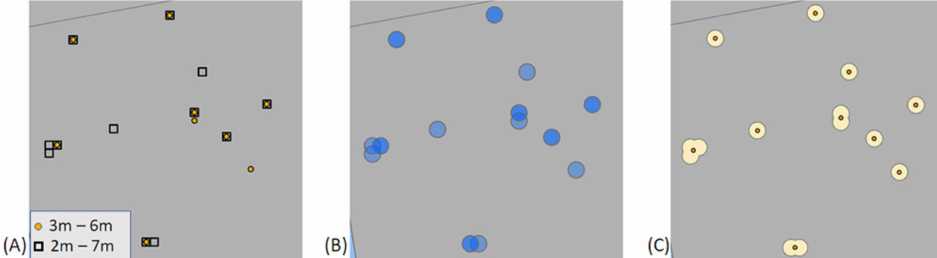
Figure 10. Summary of duplicate point merging steps in ArcGIS Pro. ( A ) The predicted tree lo- cations generated by the two-pass approach, ( B ) 0.5 m buffers around all prediction points and ( C ) overlapping buffers converted to merged polygons and new predicted tree